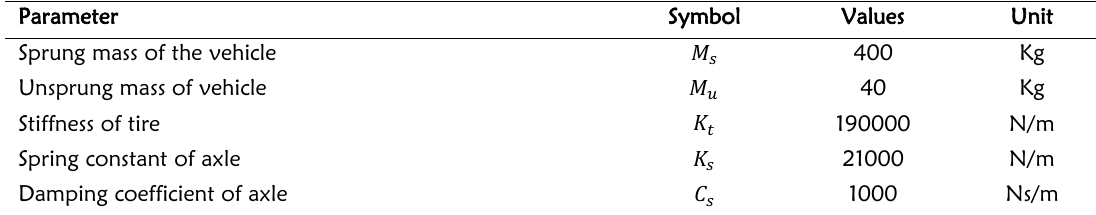
Table 1. Simulation parameters for Quarter car model